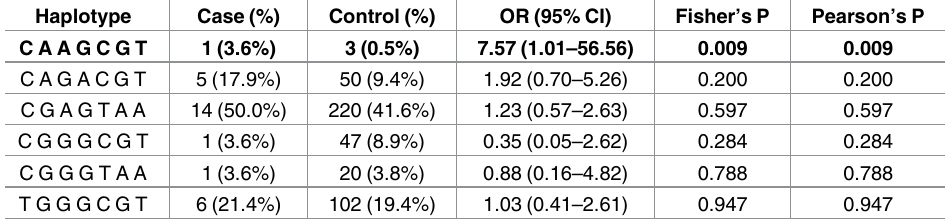
Associations that reached statistical significance were highlightedin